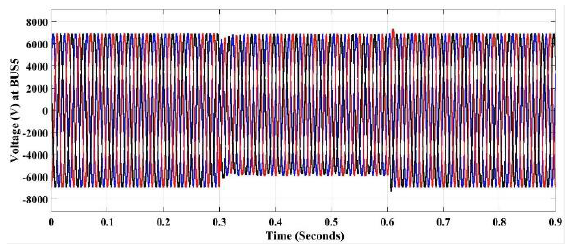
Fig.18 Voltage Sag compensated at BUS5 The faulty transmission line 3-4 is isolated at 0.3 secs, DVR compensates the voltage sag observed at load 5 due to fault at transmission line 3-4 between 0.3 to